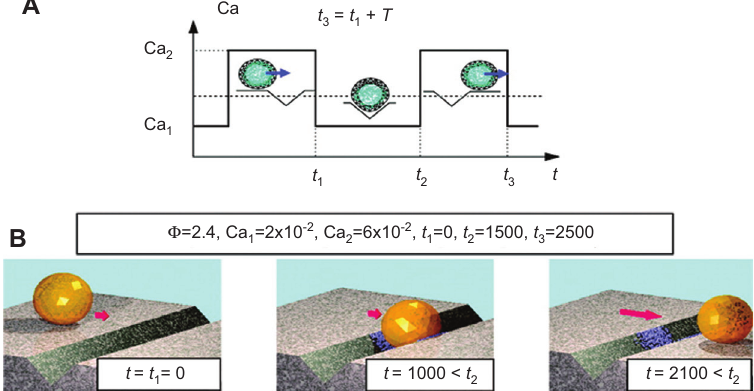
Figure 17 Schematic representation of the time dependence of capillary number (Ca) for the imposed pulsatile shear flow (A). The shear rate is changed at the time points t , t , and t . (B) Motion of the capsule for the initial position, the arrested capsule within the crack during 1 2 3 the low-shear period, and the motion of the capsule out of the crack (reprinted with permission from [84]). Copyright 2010, American Chemical